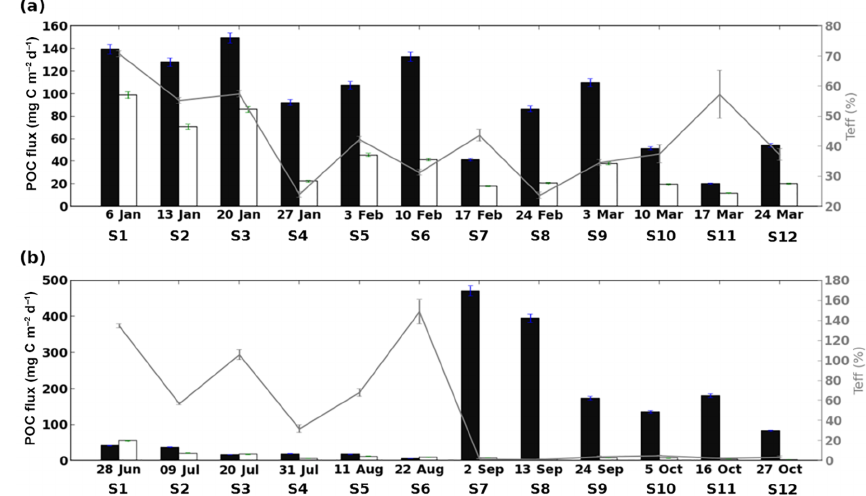
Figure 2. Time series in 2013 for POC flux (left-hand scale) at 34m (black bar) and 149m (white bar) and the corresponding transfer efficiency ( T eff ; from Eq. (1), grey line, right-hand scale), covering the AMOP summer (denoted AMOP1) (a) and AMOP winter–spring (denoted AMOP2) (b) periods. Error bars correspond to the accuracy of analytical determination for the POC flux, which is estimated through a logarithmic expansion of Eq. (1) for T eff (see Sect. 2, Tables 3a and S1 for details).